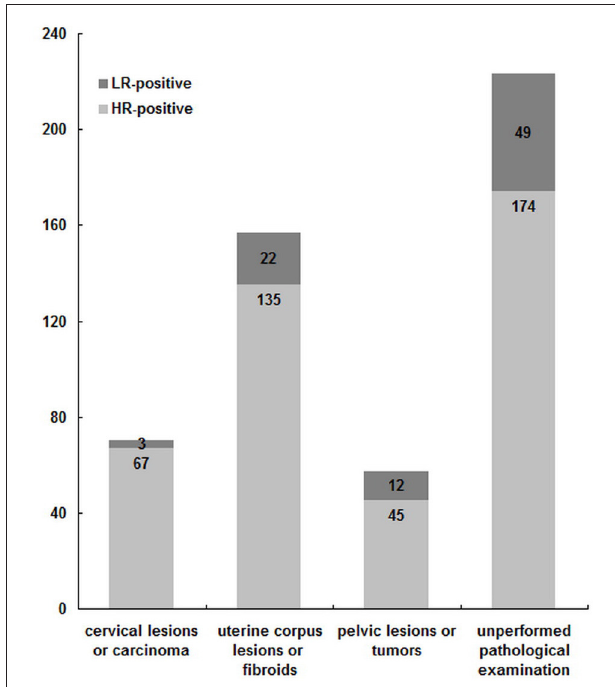
FIGURE 6 | Pathomorphism distribution among 507 HPV positive hospitalized-patients.